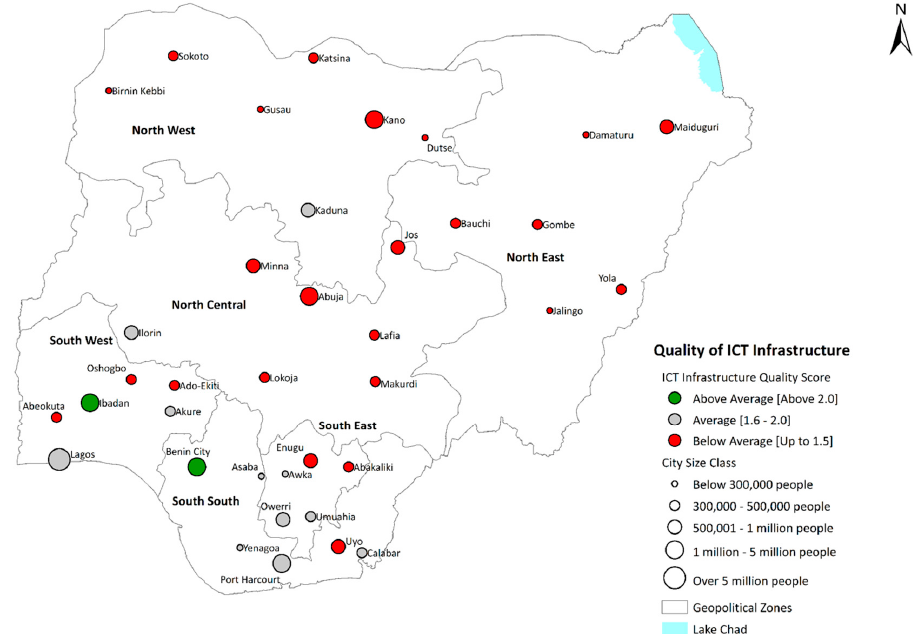
Figure 8. Quality of ICT Infrastructure 2007/2009.